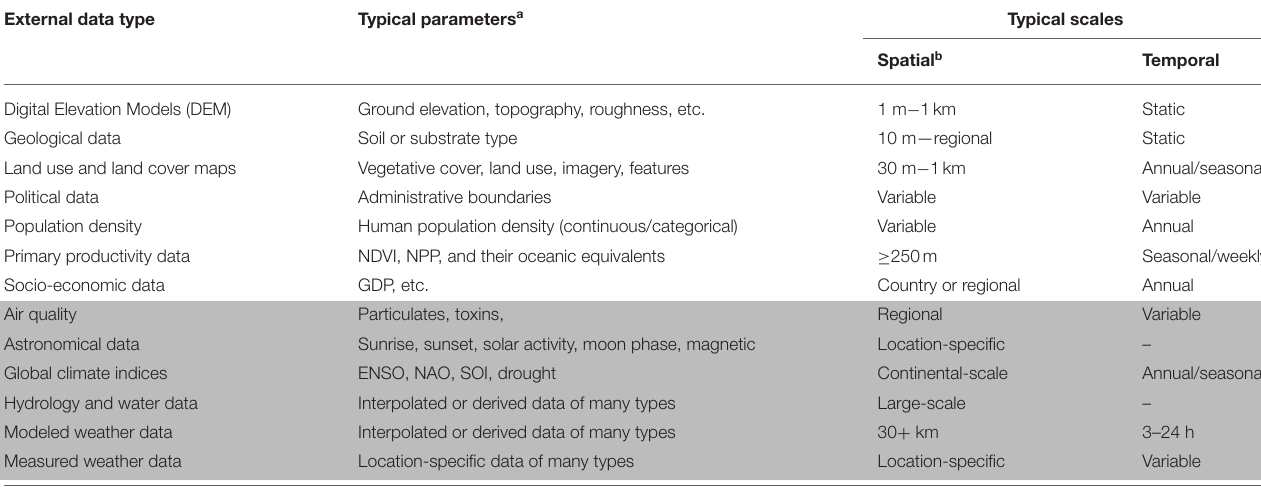
TABLE 2 | External data sets regularly associated with animal tracking or bio-logging data, some of the typical parameters in those datasets that are associated with terrestrial animal movement data, and the typical spatial and temporal scales at which the data are